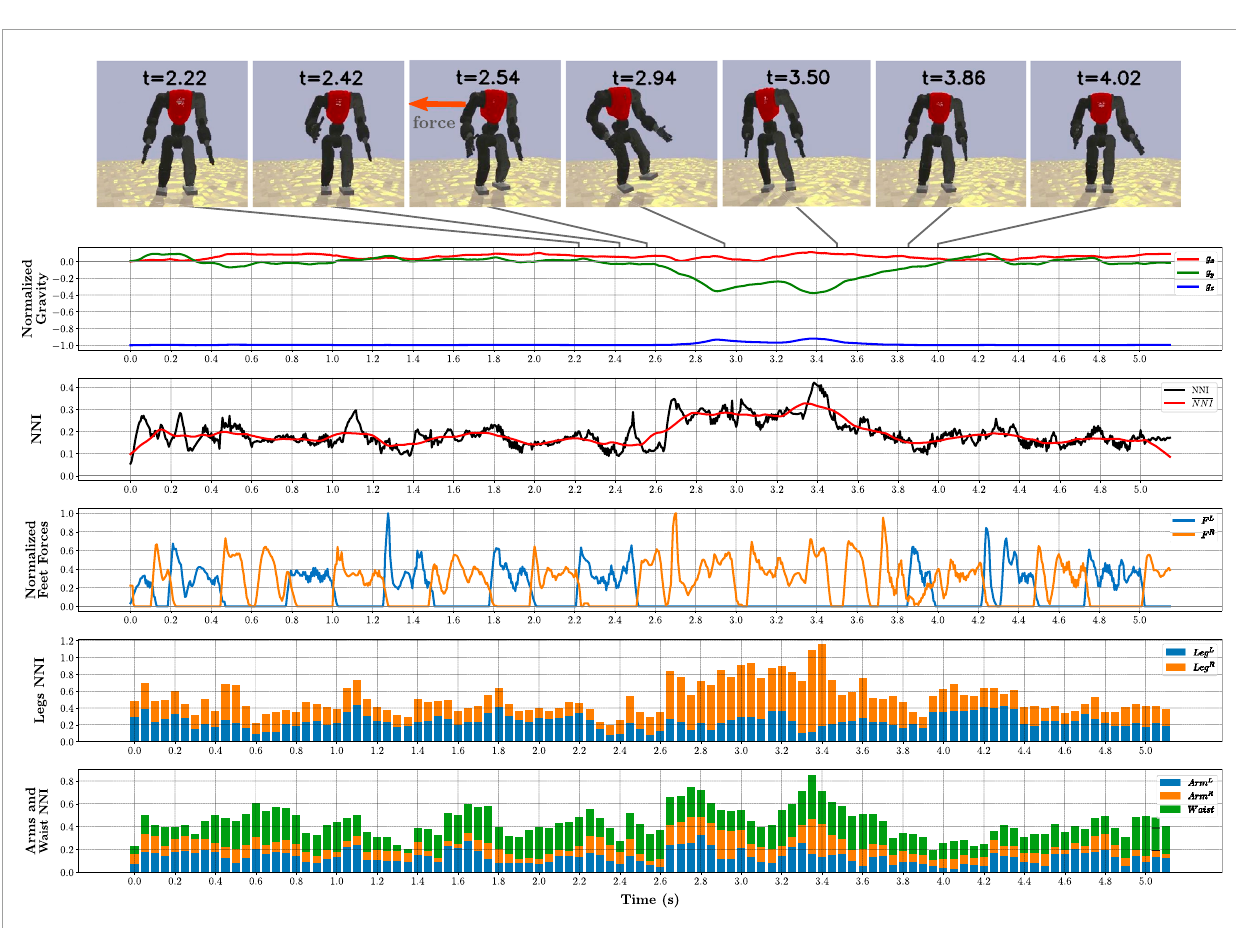
FIGURE 6 Analysis of simulation using the asymmetrical L2 policy on the L2 scenario for 5 s, with a single external push, applied to the robot’s torso for 0.025 s with a force of 850 N. Seven snapshots before and after the push are presented. During entire simulation period, different metrics were sampled at 200 Hz as: normalised gravity vector, relative to the robot’s torso; global NNI, as defined in (Eq. 6 ); normalised feet forces; and NNI per joint group.